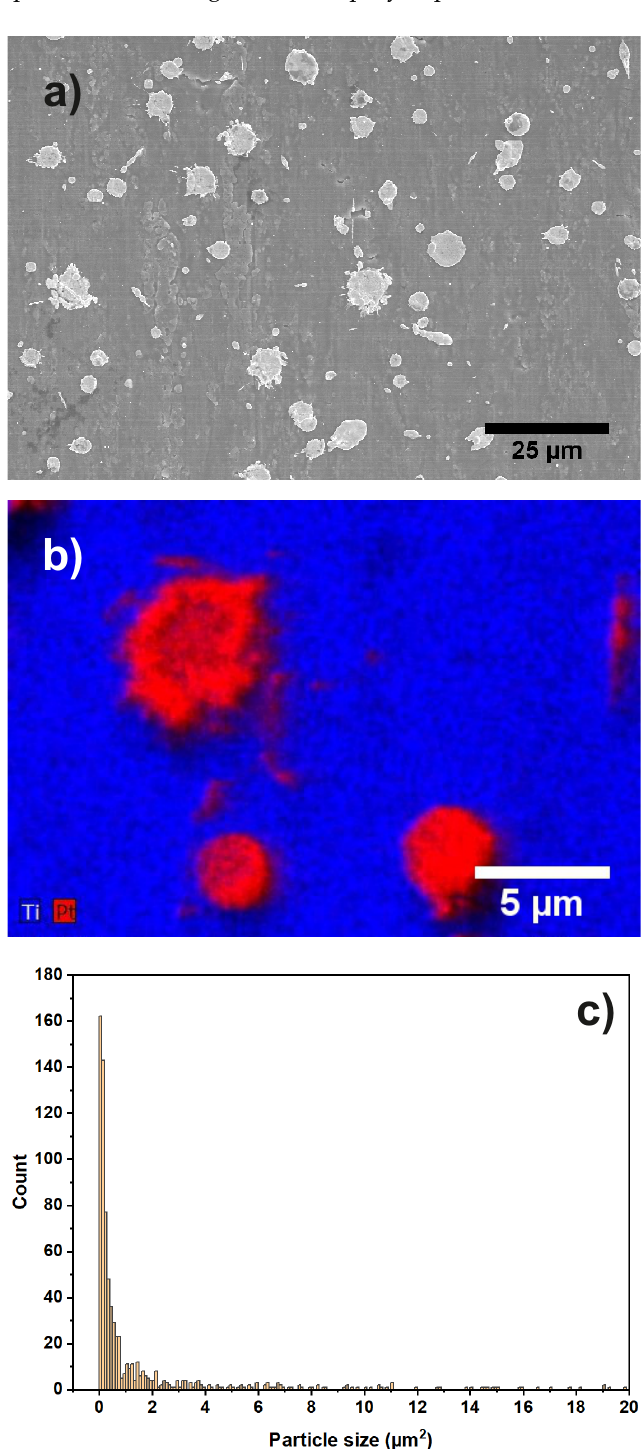
Figure 7. ( a ) SEM overview image of sample “Au/Pt”. Different shapes of Pt particles (elongated, circular, and irregularly shaped) are visible; ( b ) EDX map of several Pt particles on the Ti support; ( c ) particle size distribution of the catalyst